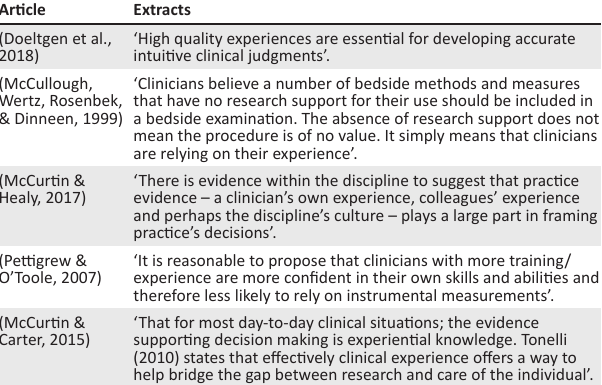
TABLE 1: Extracts regarding the value of clinical